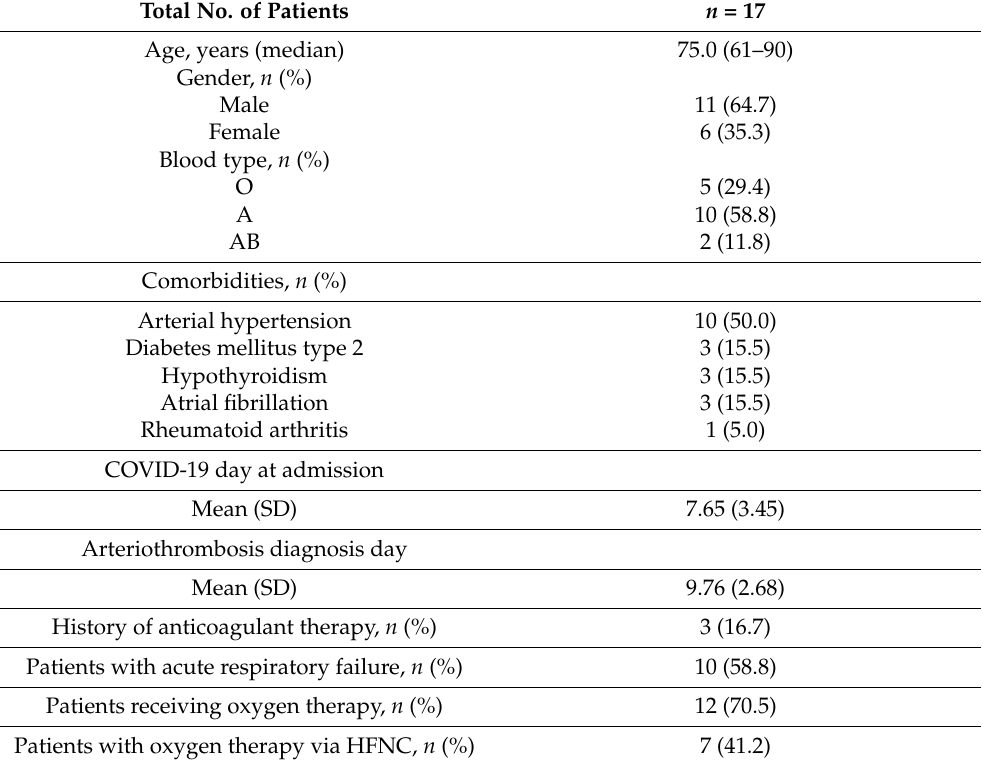
Table 1. Demographic characteristics of the patients.